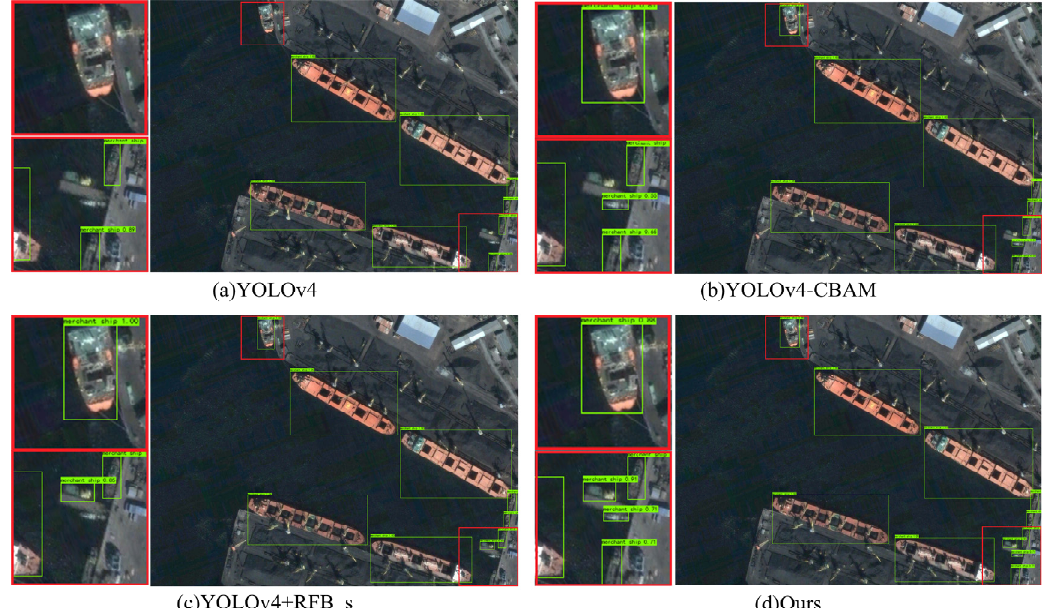
Figure 11. Comparison of ablation experiment test results. ( a ) Detection result of YOLOv4 model.